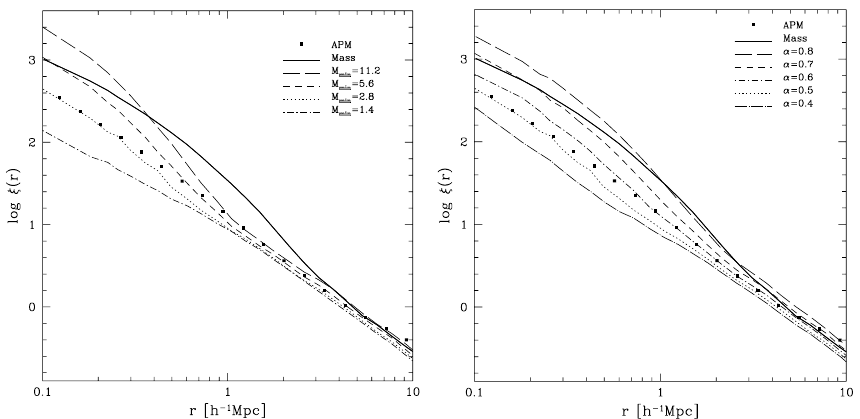
Figure 1. Figure from Berlind and Weinberg [3]. Curves show the predicted two-point galaxy correlation function obtained from halo occupation distribution (HOD) models assuming the distribution described in Equation (1). Different line styles correspond to different values of the parameters M min and α . Symbols show the measured two-point correlation function from the APMgalaxy survey